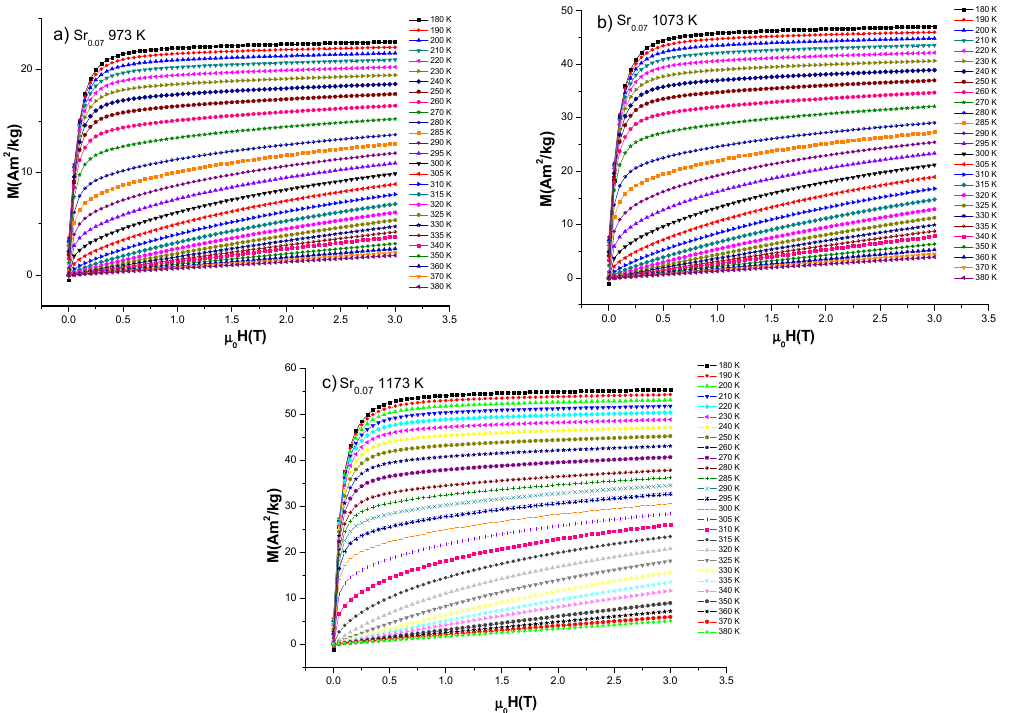
Figure 3. Magnetization isotherms for La 0.7 Ca 0.23 Sr 0.07 MnO 3 nanofibers heat treated at ( a ) 973 K, ( b ) 1073 K and ( c ) 1173 K under applied field of μ o H = 3T.